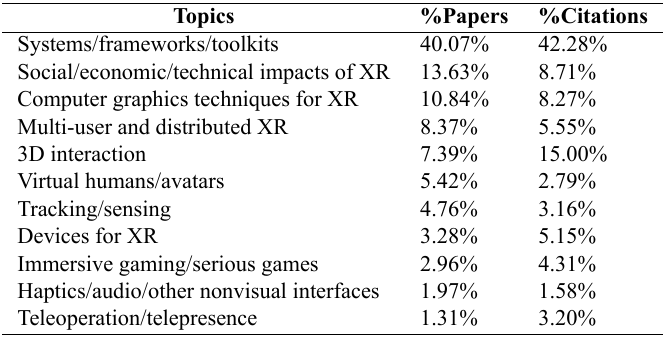
Table 1. Proportion of the cited papers related to the number of papers published for each